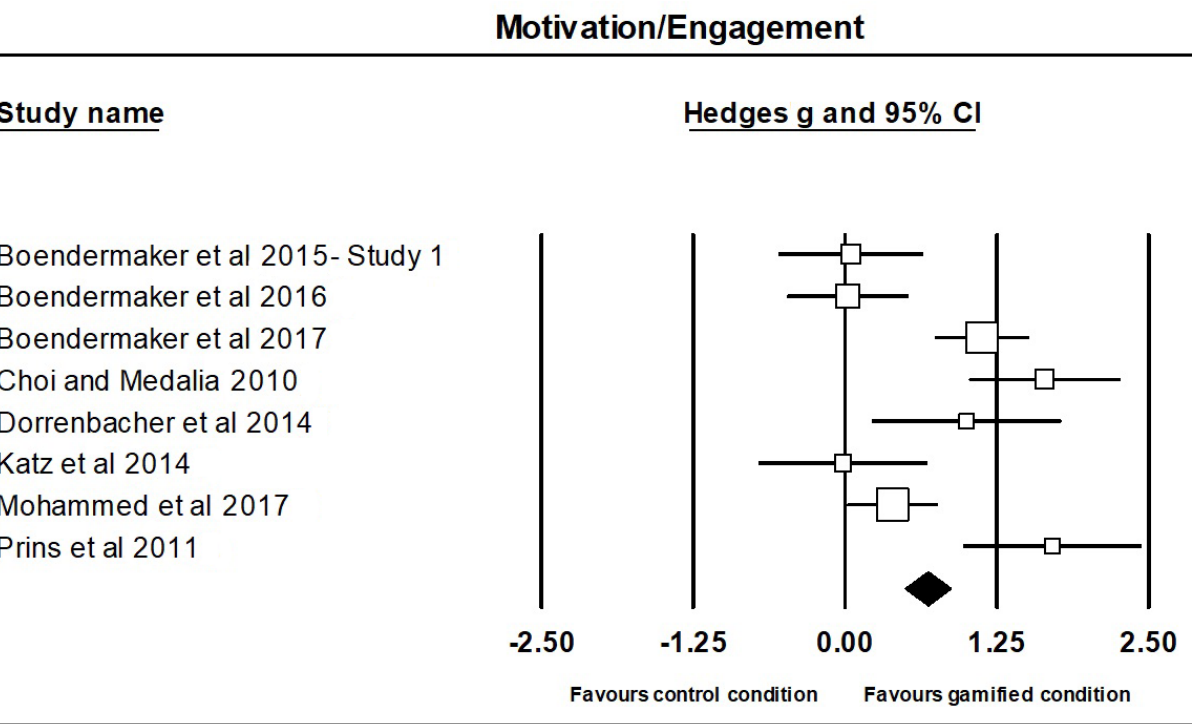
Figure 2. Forest plot of overall effect sizes comparing gamified condition and control condition (ie, non- or less-gamified version) on motivation/engagement for individual studies in alphabetical order.